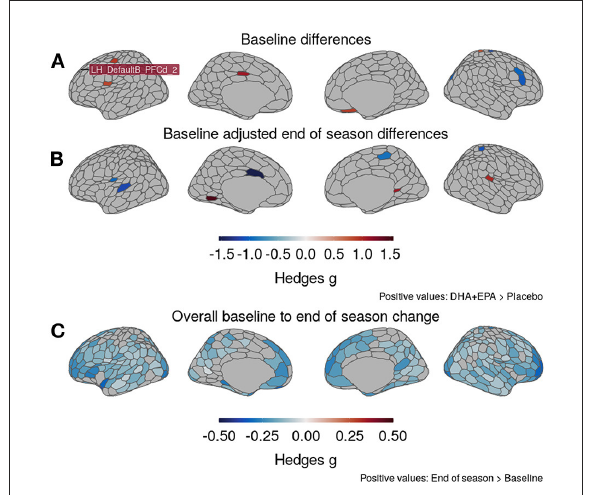
FIGURE4 Changes in gray matter volume from baseline to end of season. (A) DHA + EPA and Placebo groups exhibited moderate to large, statistically significant differences in gray matter volume in 10 regions prior to treatment. (B) Baseline-adjusted models revealed eight regions with moderate-to-large, significant between-group differences at the end of the season that differed from those at baseline. (C) Irrespective of groups, moderately large, statistically significant decreases in gray matter volume were observed in 280/473 regions, including those identified to differ between groups. No regions exhibited increased volume. Specific region names for those identified in (A) and (B) reported in Supplementary Table 2.